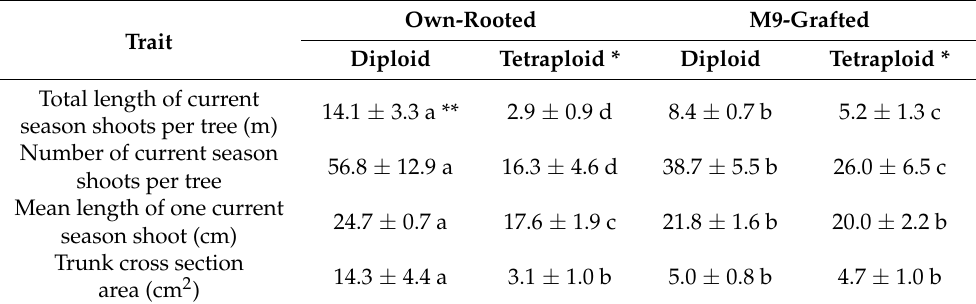
Table 2. Growth parameters of the own-rooted and M9-grafted five-year-old trees of diploid and tetraploid apple cv. ‘Redchief’ growing in an experimental orchard at the National Institute of Horticultural Research (Skierniewice, Poland). Own-Rooted M9-Grafted Trait Diploid Tetraploid * Diploid Tetraploid